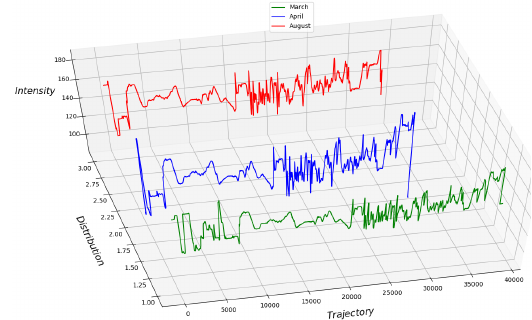
Figure 13. Measured light values for the Timis oara to Deva (path , 2) segment of A1-DN7 Three light intensity measurements are considered with the trajectory tensor having the following representation: Γ Γ Γ Γ t ( TM → DV ( II )) = f ( I 1 T , t I 2 T , t I 3 T ) As previously, from the data-set Θ ( TM → DV ( II )) it